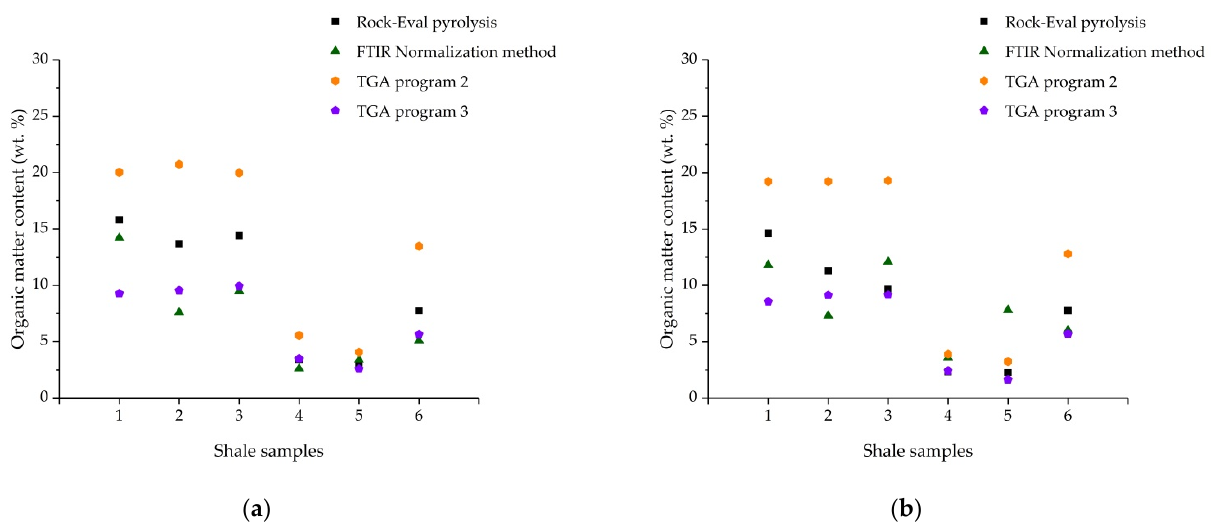
Figure 6. Comparison of organic matter (OM) content in the Bazhenov Formation rock samples after acid treatment, 1–6 ( a ) before and 1 ex –6 ex ( b ) after bitumen extraction, evaluated by Rock-Eval pyrolysis, TGA (Program 2: in the oxidizing atmosphere; and Program 3: in the inert gas) and FTIR spectroscopy in transmission mode (normalization method).